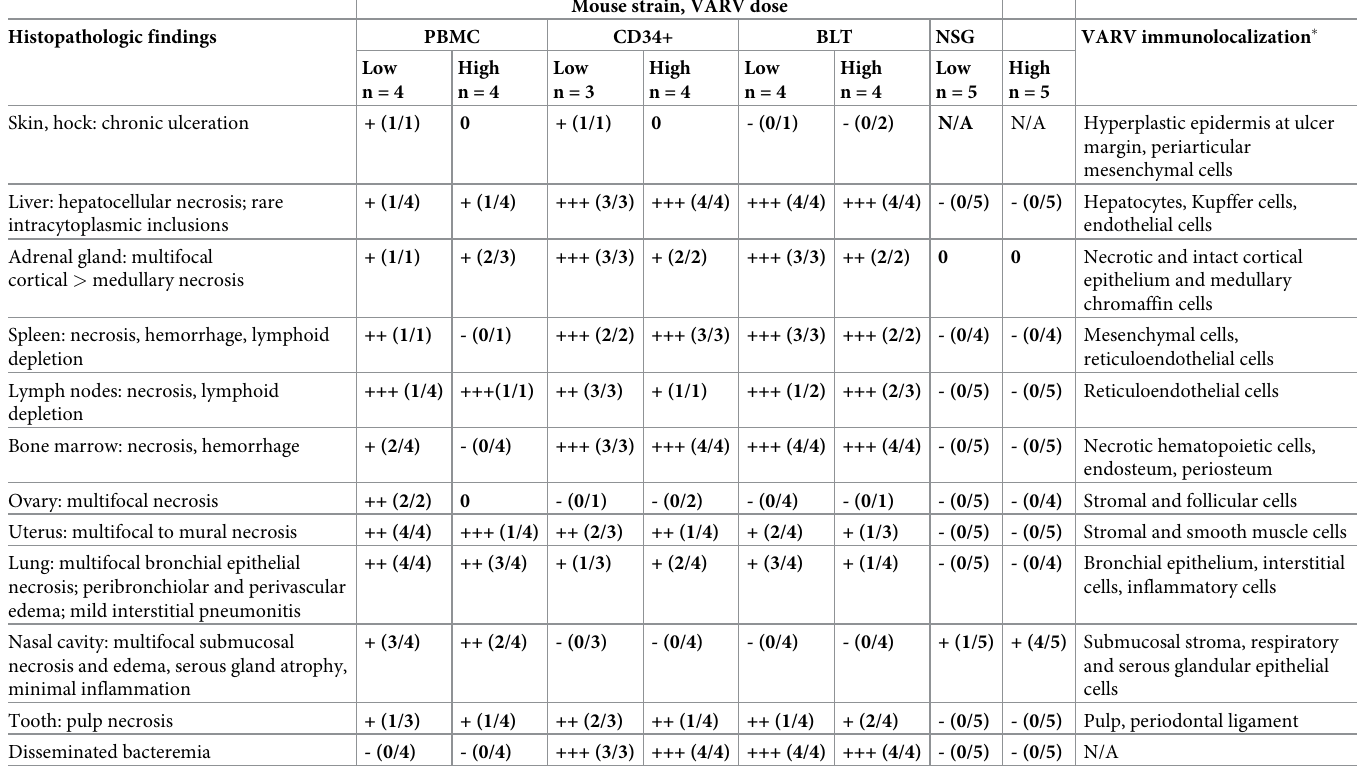
Table 2. Microscopic lesions and VARV immunolocalization in tissues from humanized (PBMC, CD34+, BLT) mice and non-humanized background strain (NSG) mice inoculated intranasally with VARV. Fractions indicate number of animals with finding divided by number of animals with tissue type collected. Mouse strain, VARV